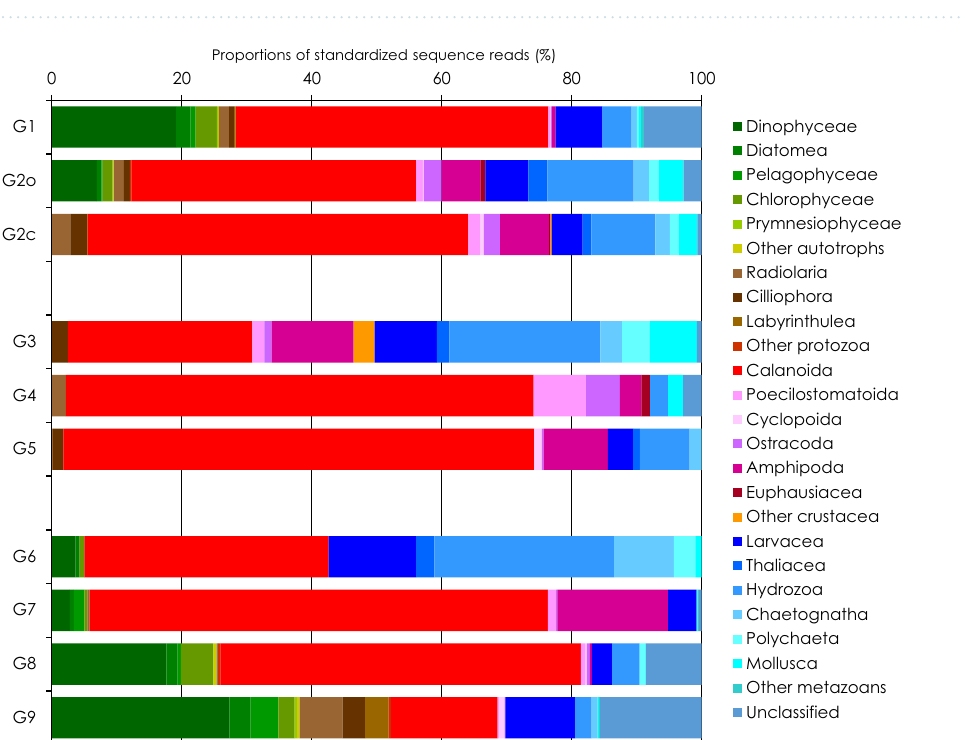
NMDS plot, with overlapping for some Calanidae ( Neocalanus gracilis and Undinula vulgaris ) and Metridinidae species ( Pleuromamma gracilis and P. abdominalis ) (Fig. 4c). Omnivorous calanoid species were plotted toward the right side, while Aetidius and Chiridius species were found at the bottom and segregated from the other omnivorous copepods because of their preference for gelatinous prey. The other omnivorous species were allo- cated toward the left side because their prey spectra were narrower than those of copepods. At 30% Bray–Curtis similarity, the omnivorous species were classified into four groups (G6, G7, G8 and G9). Their prey proportions were characterized by the next most contributed prey after the highest contribution from calanoids: gelatinous prey represented by larvaceans and hydrozoans for G6, amphipods for G7, and dinoflagellates for G8. G9 had the highest contribution from dinoflagellates and wider prey spectra than the other groups.